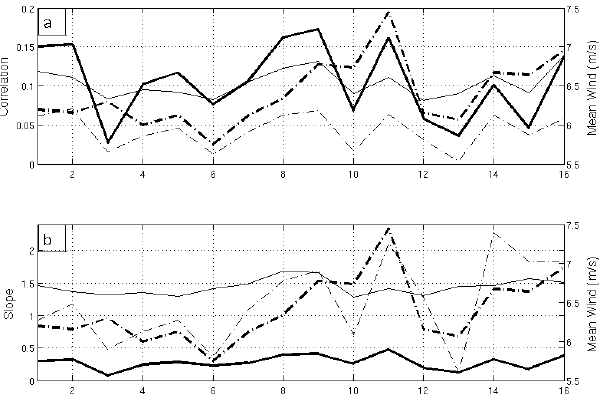
Figure 10. Correlations (a) and slopes (b) between T 0 × V 0 (thick continuous line), ( ∇ . u ) 0 × (∂T/∂d) 0 (thin continuous line) and − ( ∇ × u ) 0 × (∂T/∂c) 0 (thin dash-dotted line) and the mean wind speed (thick dash-dotted line) for the 16 Agulhas rings identified in the present study. A remarkable concordance between the correlations and slopes with the wind speed is observed.